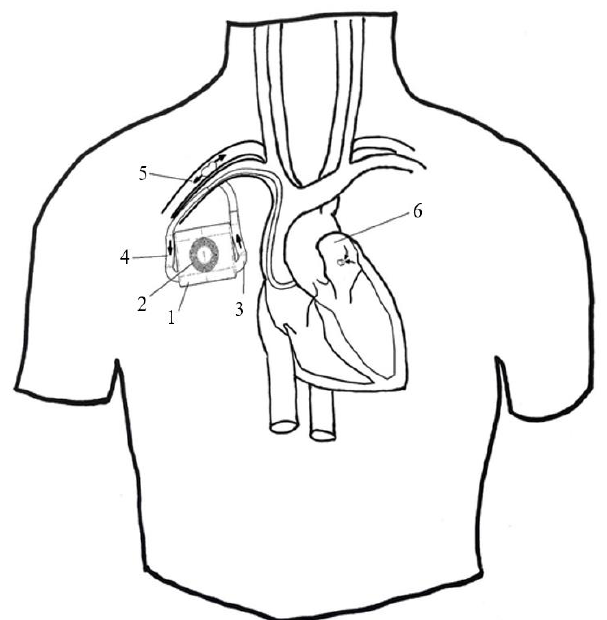
Figure 1. The circulatory assist device—example of implantation in a subcutaneous pocket with inflow cannula connected endovascularly to the left atrium and the outflow cannula in the subclavian artery. Legend: 1: device, 2: antenna, 3: outflow cannula, 4: inflow cannula, 5: subclavian artery, 6: left atrium.